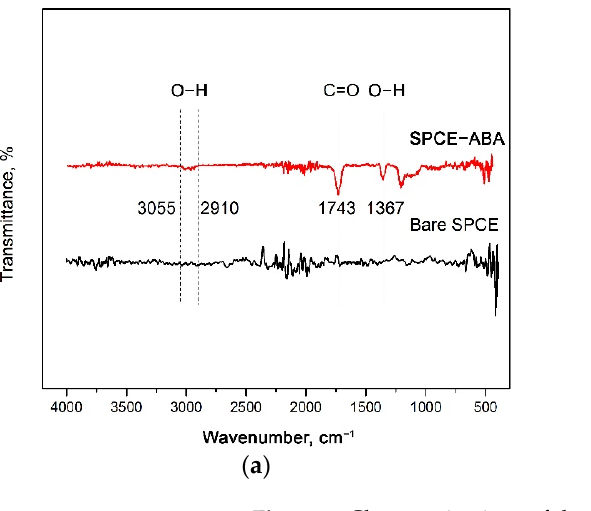
Figure 4. Characterizations of the diazonium-modified electrode ( a ) FTIR spectra of bare SPCE and SPCE-ABA layer. ( b ) Representative optical images for contact angle measurements on different electrode surfaces (i) bare SPCE, (ii) SPCE-ABA, and (iii) SPCE-ABA-EDC/NHS-Aptamer.